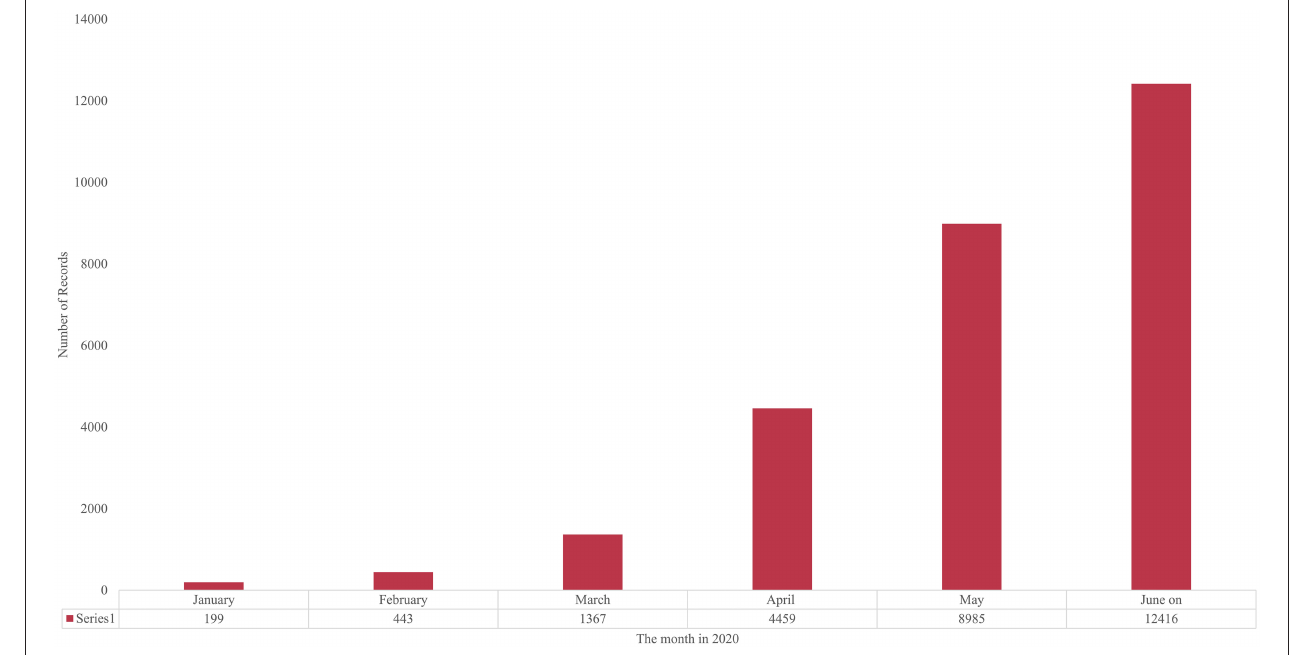
FIGURE 1 | Growth in COVID-19–related Publications Indexed by PubMed, Monthly, January-June,